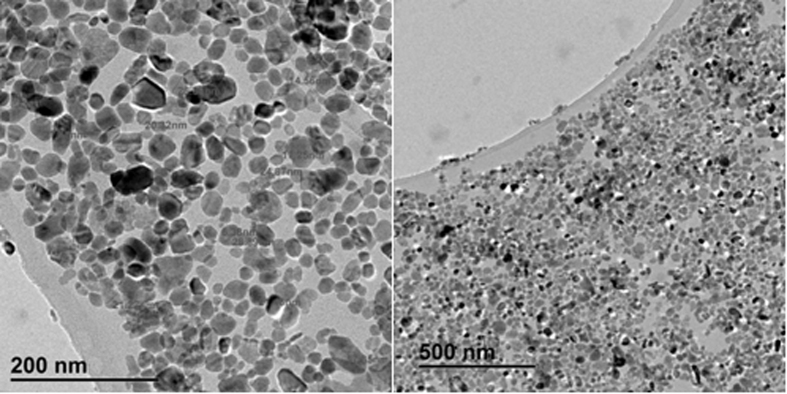
TEM images of nZnO.